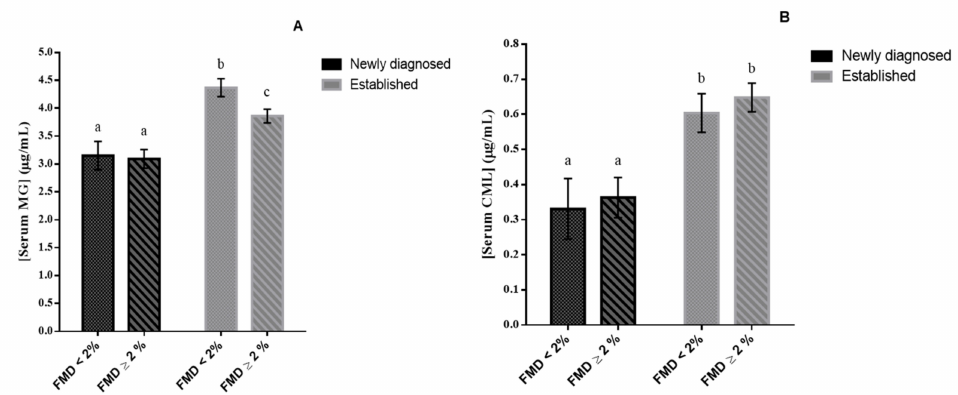
Figure 2. ( A ) Serum levels of methylglyoxal ( µ g / mL) and ( B ) carboxy-methyl-lysine ( µ g / mL) according to FMD classification (2% cuto ff ) in T2DM patients studied. One-way ANCOVA results (adjusted mean ± SEM) controlling for age, sex and BMI. Bars with di ff erent superscript letters (a, b, c) are significantly di ff erent ( p <